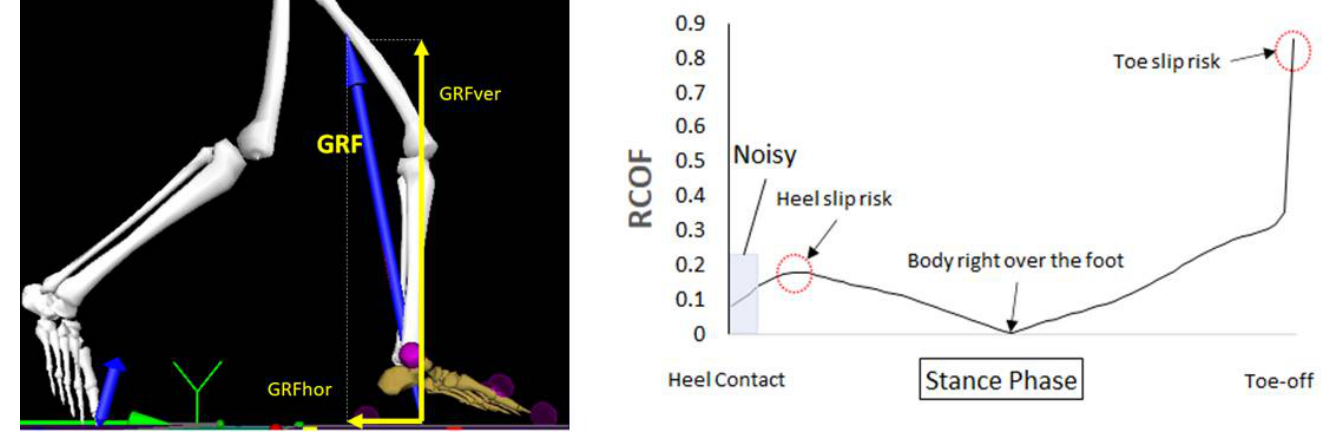
Figure 4. ( Left ) Characteristics of ground reaction forces (GRF) in the sagittal plane, with GRFver/hor indicating vertical/horizontal components, respectively; ( right ) required coefficient of friction (RCOF) characteristics throughout the stance phase.